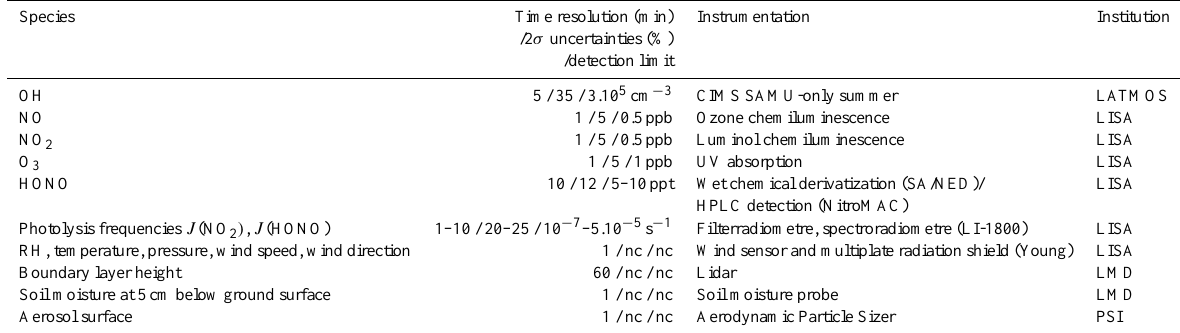
Table 1. Measurements and techniques deployed during the MEGAPOLI campaigns at SIRTA observatory. Species